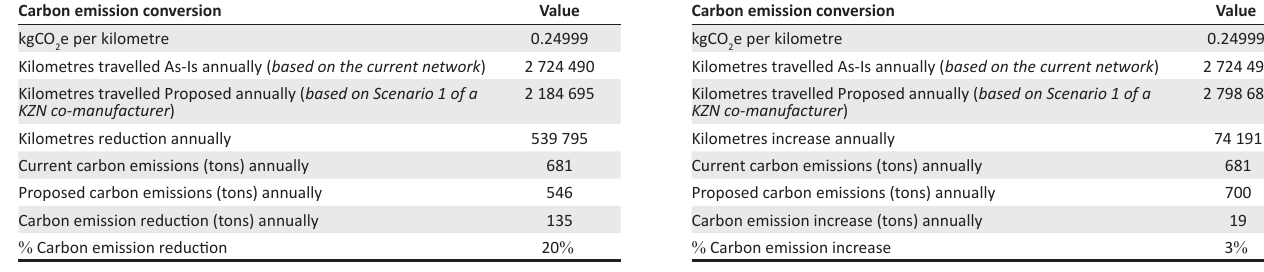
FIGURE 4: Best practices related to the sourcing process using Green supply chain operations reference. TABLE 11: Source case study scenario 1: Overall carbon emission reduction. TABLE 12: Source case study scenario 2: Overall carbon emission